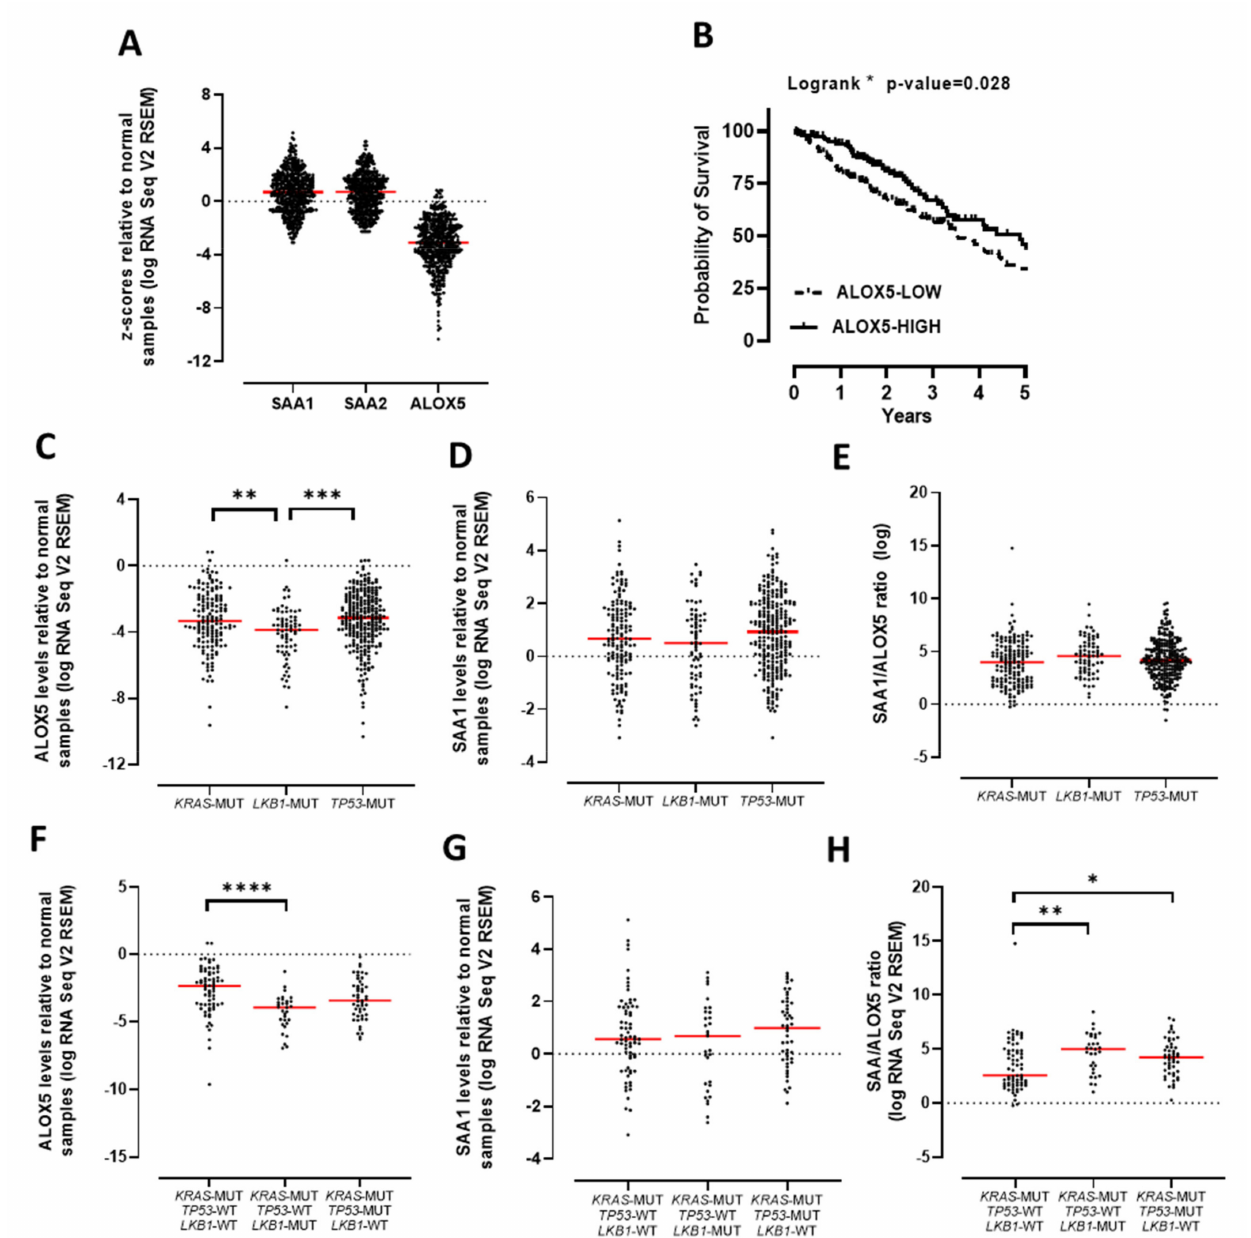
Figure 3. TCGA dataset analysis validate that ALOX5 expression is reduced in lung tumours. ( A ) SAA1, SAA2 and ALOX5 gene expression derived from the TCGA RNA Seq lung adenocarcinoma dataset were expressed relative to normal tissue. ( B ) Kaplan–Meier plot of overall survival for lung adenocarcinoma patients stratified by low (lower 33rd percentile) and high (upper 33rd percentile) ALOX5 expression (data from OncoLnc). ( C ) ALOX5 gene expression stratified into KRAS, TP53 or LKB1 mutated (MUT) tumours. ( D ) SAA1 gene expression stratified into KRAS, TP53 or LKB1 mutated tumours. ( E ) The SAA1/ALOX5 ratio presented according to tumour genotype. ( F ) ALOX5 levels relative to normal samples. ( G ) SAA1 levels relative to normal samples. ( H ) SAA/ALOX5 ratio. **** p < 0.0001, *** p < 0.001, ** p < 0.01, * p <